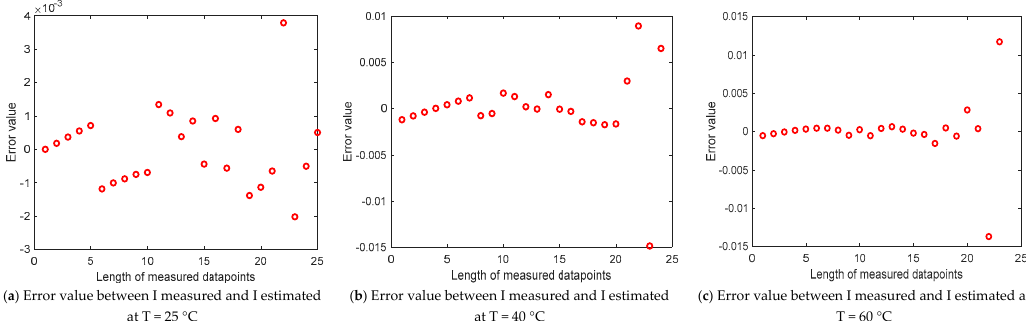
Figure 21. Depiction of the measured and simulated data obtained by MJSO on SM55 under different T.